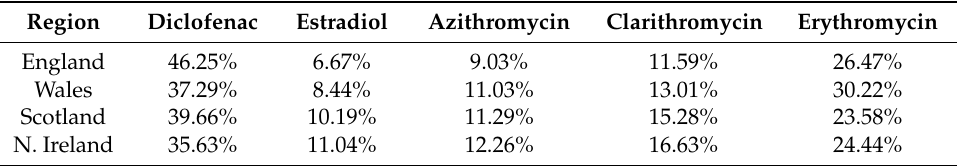
Table 3. Percentage Averages from 2004 to 2014 for the five examined substances in England, Wales, Scotland, and Northern